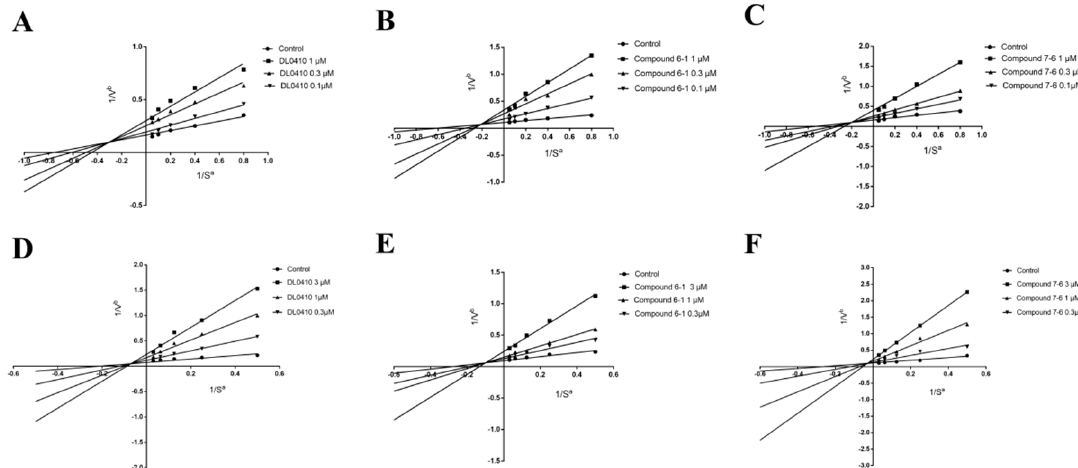
Figure 6. The Lineweaver-Burk plots of DL0410, compound 6-1 and compound 7-6 on AChE inhibitory activity ( A – C ). The Lineweaver-Burk plots of DL0410, compound 6-1 and compound 7-6 on BuChE inhibitory activity ( D – F ). Kinetic analysis of AChE and BuChE was performed by using three effective concentrations of DL0410, compound 6-1 and compound 7-6 (0.1, 0.3, 1 µ M for AChE, and 0.3, 1, 3 µ M for BuChE) with the incubation of five different substrate concentrations (1.25, 2.5, 5, 10, 20 mM for AChE, and 2, 4, 8, 16, 32 mM for BuChE). The intersections of fitting lines with different concentrations of the three compounds were neither on the X axis or Y axis of Lineweaver-Burk plots of both AChE and BuChE, suggesting that DL0410, compounds 6-1 and 7-6 were mixed-type of inhibitors. ( n = 3; a = mM − 1 ; b = min/ ∆ A).